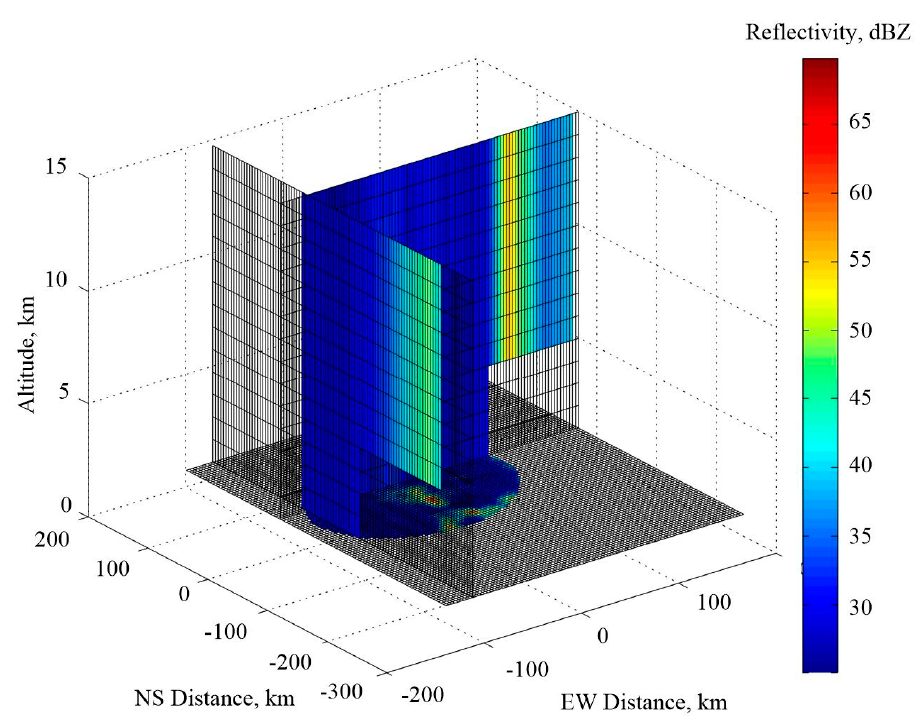
Figure 21. Description is the same as in Figure 16, except for the relevant positive lightning leader onset indicated by Case #12 and slicing planes that are forward through the point, indicated by coordinates: x = − 79.7 km, y = 29.2 km, z = 1 km. Again, the slicing cross-section altitude was increased here, from 0.3 km to its indicated value of 1 km.